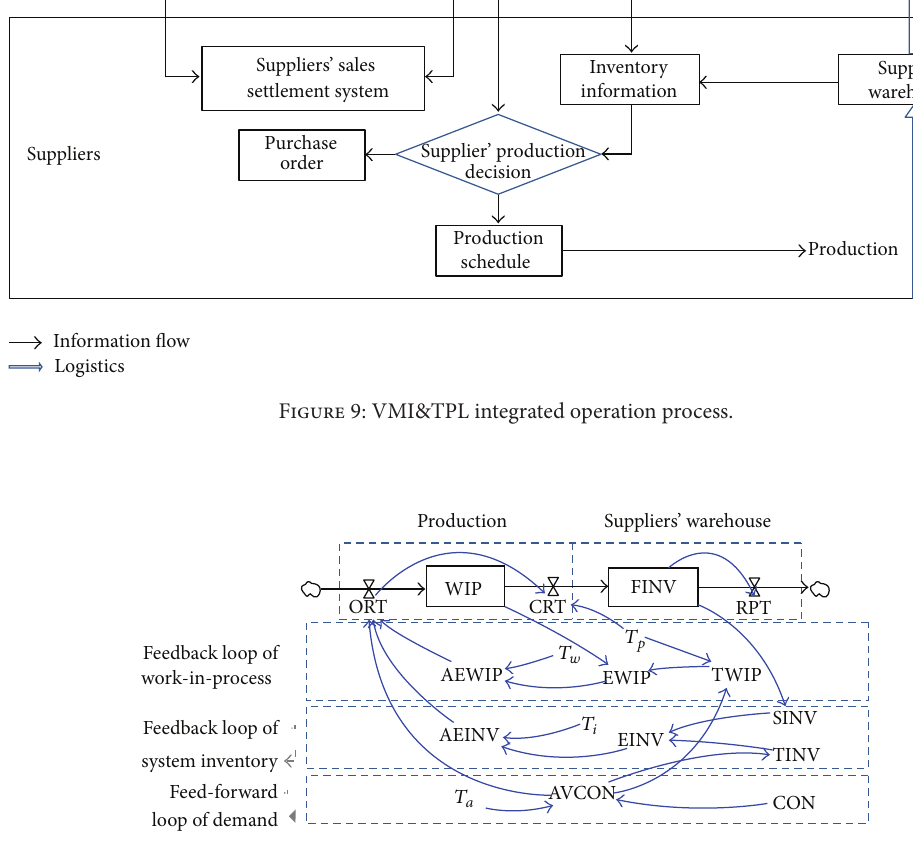
Figure 10: Causality diagram of suppliers’ production